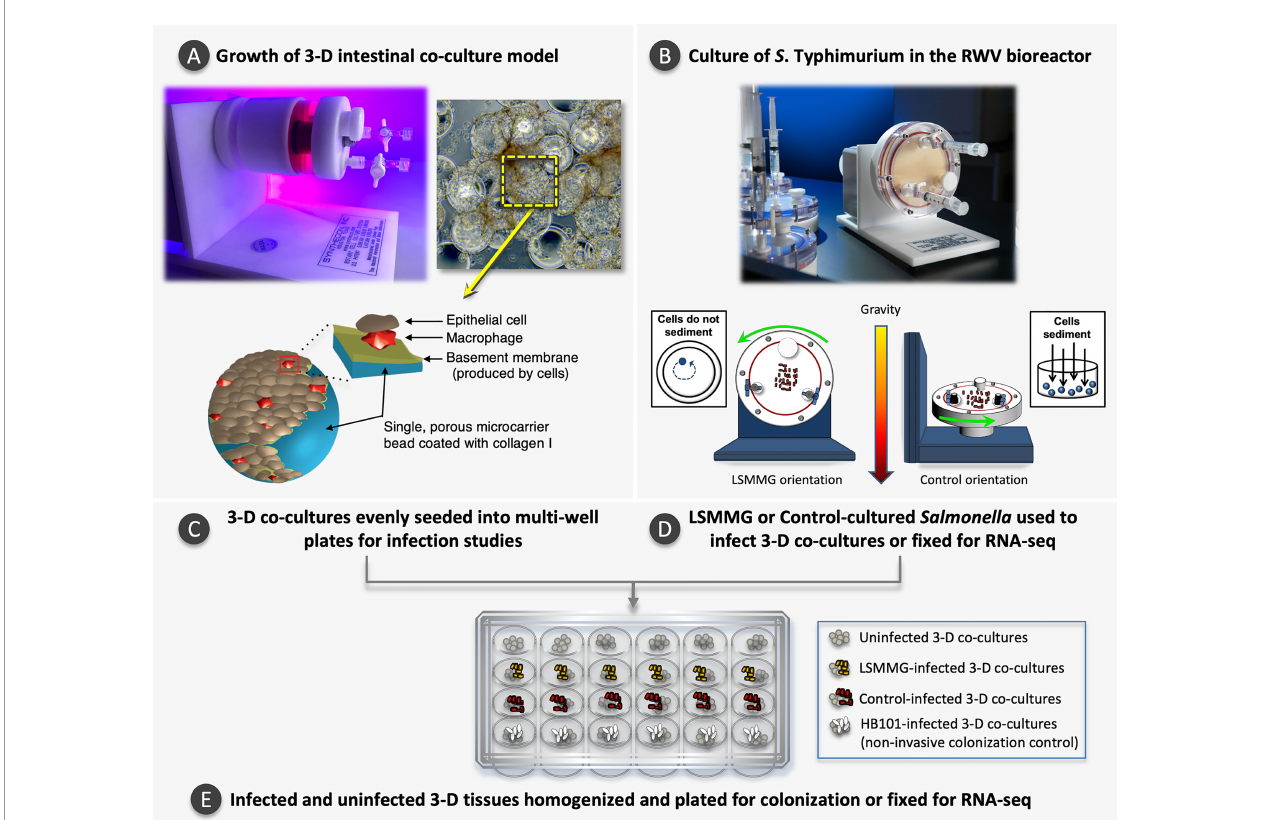
FIGURE 1 | Experimental overview. (A) Photo of a slow turning lateral vessel (STLV) bioreactor used to grow the 3-D intestinal co-culture model. During model growth, cells attach to porous, collagen I-coated microcarrier beads. The graphic inset depicts a single microcarrier bead coated with collagen I, macrophages and epithelial cells. As the model matures, individual cell-bead complexes aggregate to form larger 3-D structures, as shown in the light micrograph (magni fi cation 200X). The yellow box highlights a single microcarrier bead within a larger 3-D aggregate. STLV image reproduced with permission: © American Society for Microbiology, Infect Immun 86:e00282-18, 2018. Light micrograph and bead schematic reproduced with permission from Barrila and Yang et al., 2017 with slight modi fi cation of the labels and addition of the (Barrila et al., 2017) under CC by 4.0 (https://creativecommons.org/licenses/by/4.0/legalcode). (B) Photo of a High Aspect Ratio Vessel (HARV) bioreactor used to culture S. Typhimurium and a schematic depicting the two bioreactor orientations used in this study. In the LSMMG orientation, the solid body rotation of the media maintains the bacteria in suspension under low fl uid shear conditions. In the control orientation, the bacteria sediment to the bottom of the vessel during rotation, experiencing increased fl uid and frictional shear forces. Images reprinted by permission from Springer Nature, Barrila et al., 2016. (C) Once the 3-D models have fully differentiated, they are evenly seeded into multi-well plates. (D, E) S . Typhimurium is cultured to stationary phase under LSMMG or control conditions and used to infect a subset of the 3-D co-cultures for the gentamicin protection assay or fi xed for RNA-seq. Controls included both time-matched uninfected host cells and a non-invasive HB101 strain. At speci fi ed time points, samples in individual wells are lysed, serially diluted, and plated to obtain colony counts or are fi xed for RNA-seq